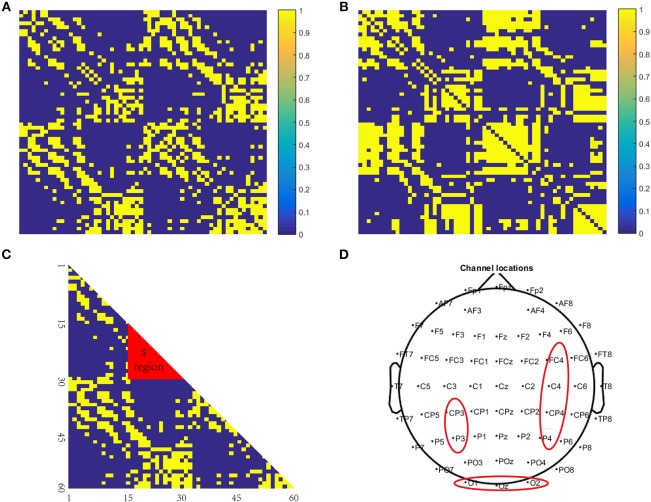
Brain network structure. (A) is a binary matrix constructed using the healthy controls; (B) is a binary matrix constructed using the patient subjects; (C) is the difference significant area S, a mathematical representation of (A,B,D) is a brain electrode position diagram corresponding to a (C) S region in the brain map.